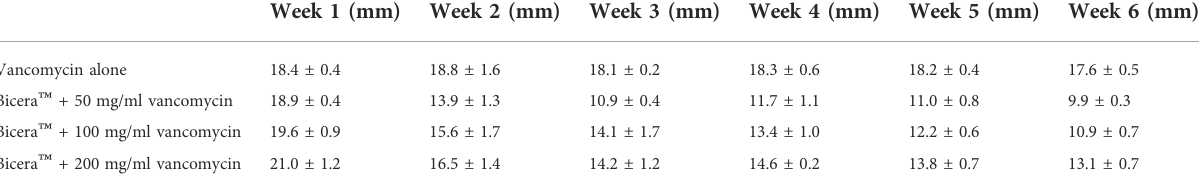
TABLE 2 The inhibition zone size of MRSA caused by vancomycin alone or vancomycin-loaded Bicera ™ .